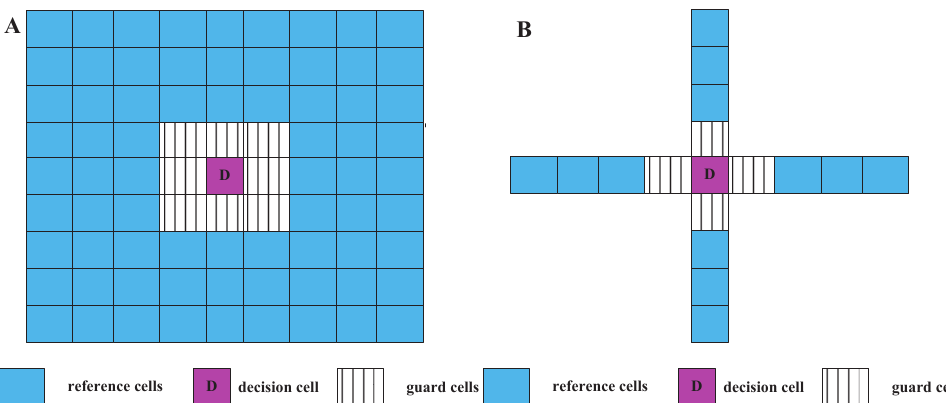
Figure 2. Structural diagrams of sampling windows: ( A ) rectangular sampling window; ( B ) cross window sampling window.